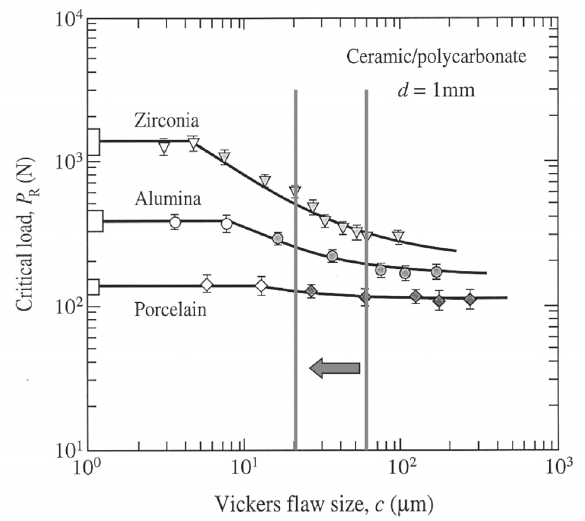
FIGURE 6 - Critical load for flexural radial cracking, P ceramic layers with inner surface flaws from Vickers indentations at specified loads. The vertical bars indicate the range estimated for flaws created with 50 µm alumina particle abrasion of these ceramics